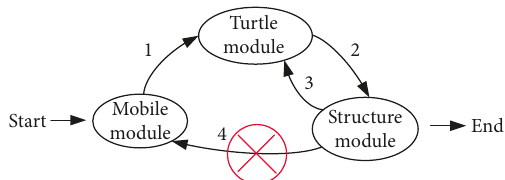
Figure 8: State translation of modules during self-recon fi